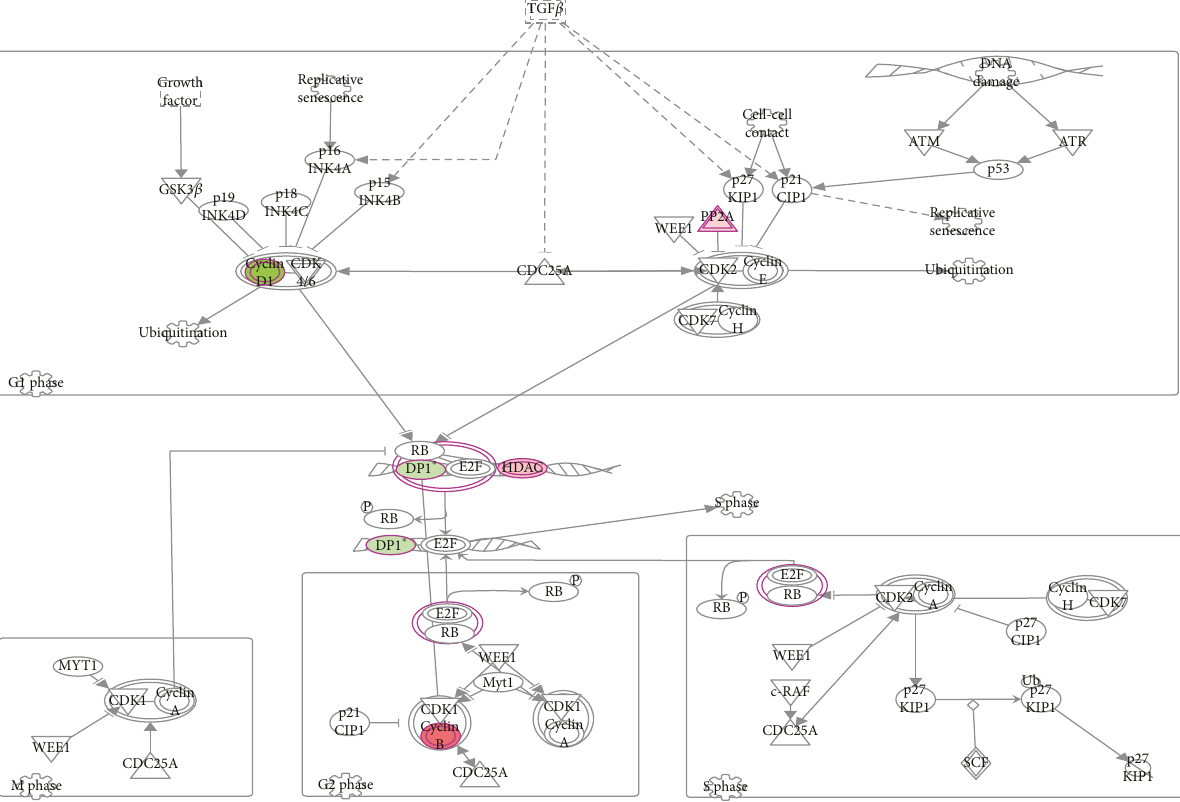
Figure 4: Cyclins and cell cycle regulation is the top pathway downregulated by citalopram treatment. This fi gure represents the cyclins and cell cycle regulation pathway as the top signaling pathway downregulated with a signi fi cant p value ( p value =1.98 E − 02) due to citalopram treatment. IPA identi fi es this pathway as it involves di ff erentially methylated genes from our dataset like cyclin B, HDAC, and P2A that are upregulated (red) and cyclin D1 and Dp1 that are downregulated (green). The color intensity is proportional to the extremity of upregulation or